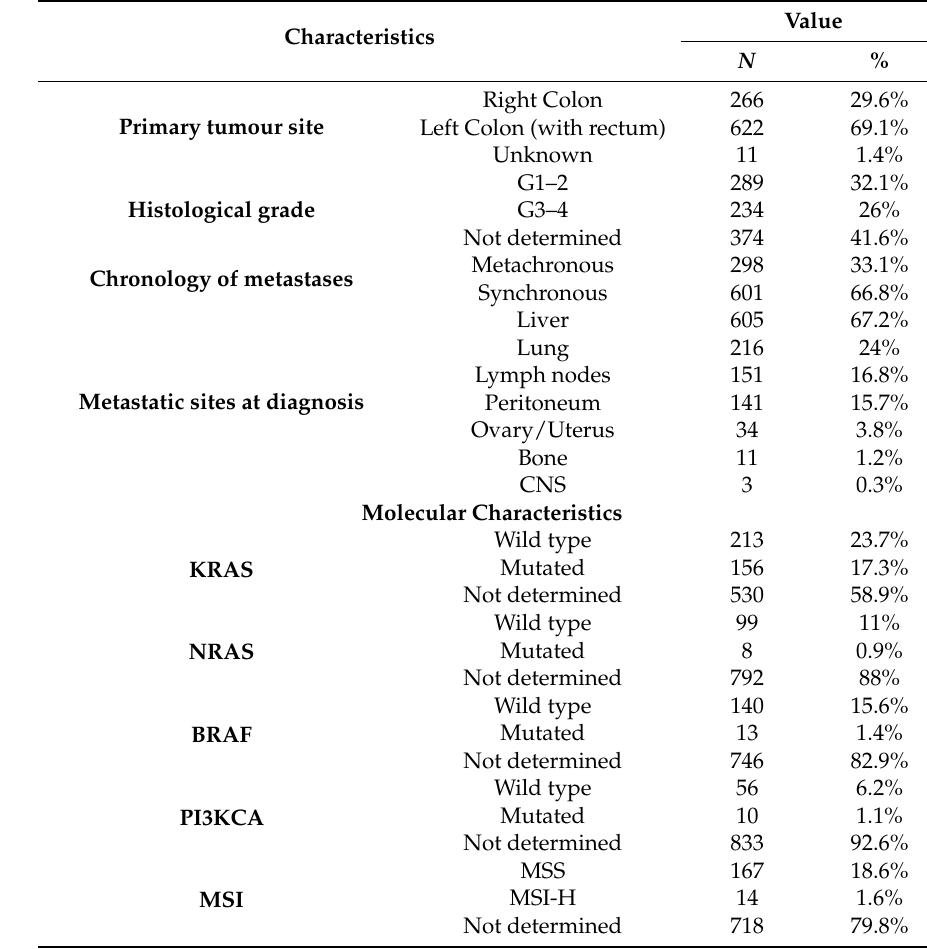
Table 1. Population